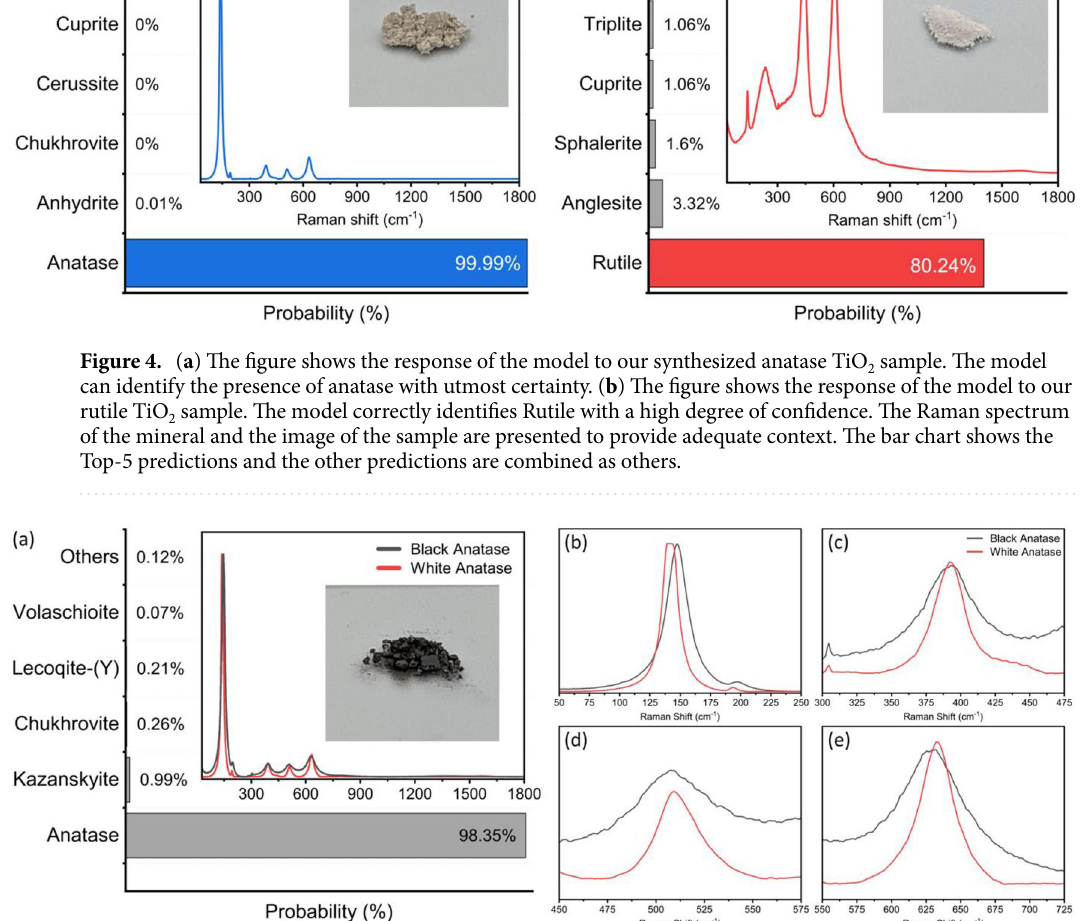
Figure 5. ( a ) The figure shows the response of the model to defect-rich black Anatase. ( b – e ) shows a detailed comparative view of the four main peaks in the Raman spectra of defect rich black Anatase and Standard white Anatase. The model correctly identifies Anatase in the modified spectra with a slightly lower level of confidence. The ability of the model to correctly characterise the modified spectrum shows the generalisation power of the model. The Raman spectrum of the mineral and the image of the sample are presented to provide adequate context. The bar chart shows the Top-5 predictions and the other predictions are combined as